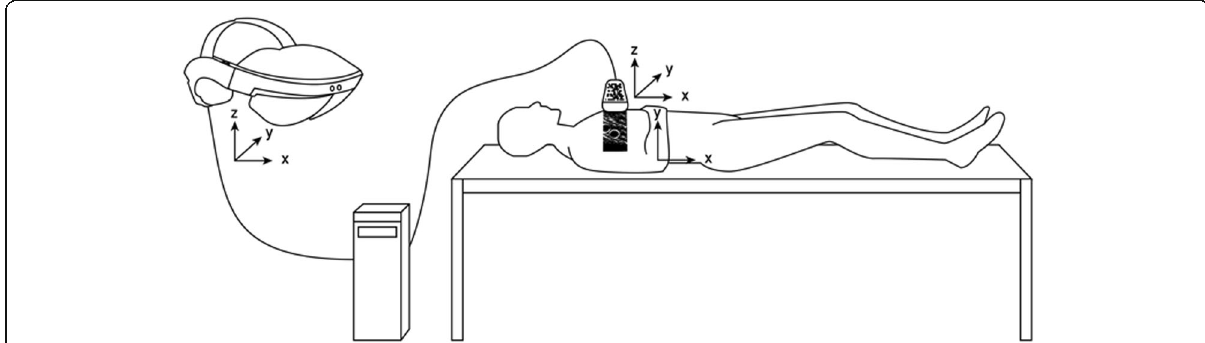
Fig. 1 AR in situ US system with the AR headset, the computer, where the spatial mapping of the US image is calculated by the custom software and the transducer showing its physically attached tracking pattern. Not shown here: the standard US that is providing the US image data to the software on the computer. AR Augmented reality, US